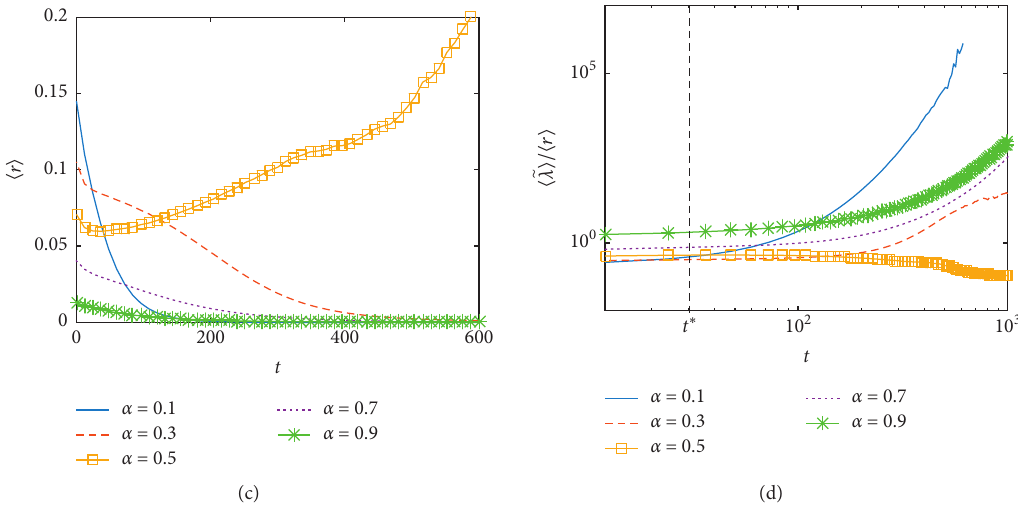
Figure 4: Plots of the critical parameters versus t for typical values of α . (a) Top pane: time evolution of the average donation rate 〈 q 〉 . Bottom pane: the evolution of average number of infected neighbors of all nodes 〈 m 〉 . (b) Time evolution of the average infection rate 〈 􏽥 λ 〉 . (c) The complete evolution of the average recovery rate 〈 r 〉 . (d) Log-log plots of the average effective infection rate 〈 􏽥 λ 〉 / 〈 r 〉 . Basic infection rate is fixed at λ � 0 . 04. The results of the simulations are obtained by averaging over 300